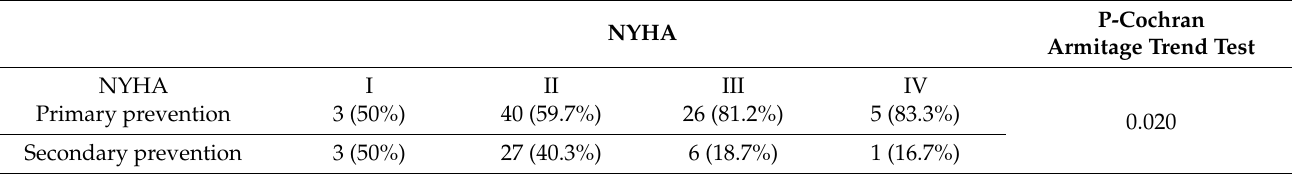
Table 2. NYHA class distribution, according to type of